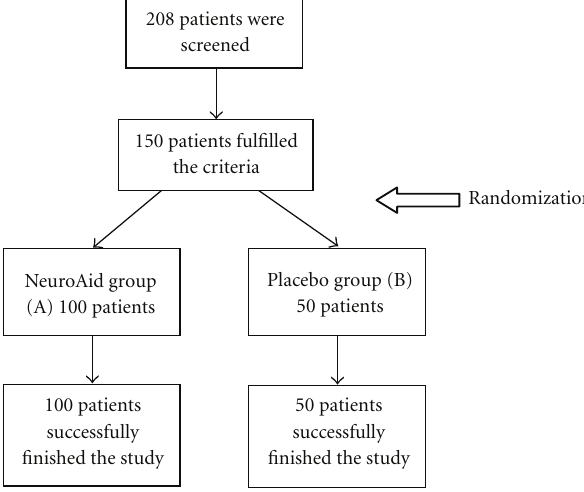
Figure 1: The study